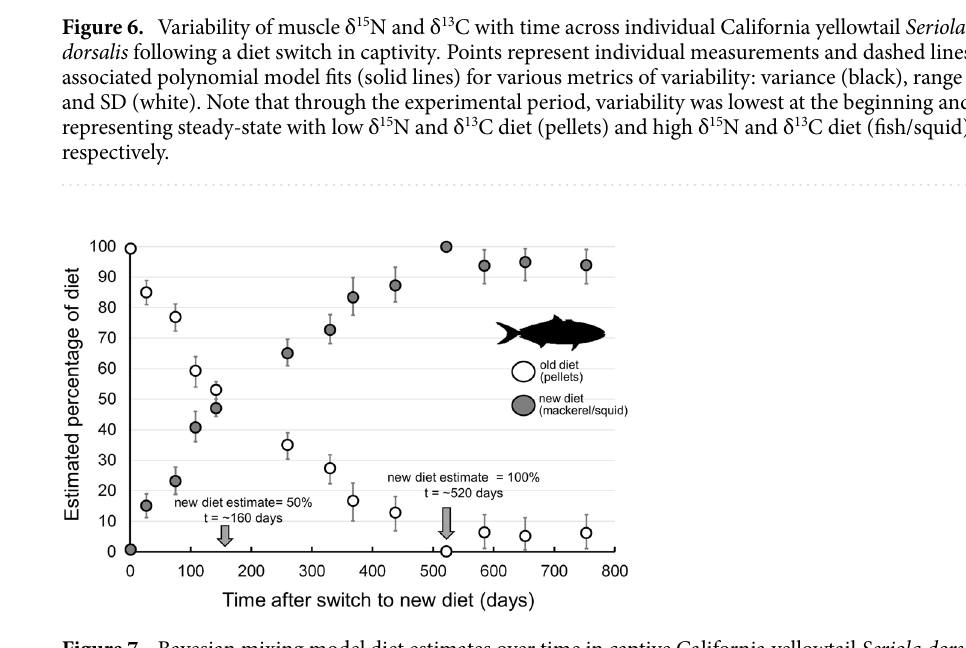
Figure 7. Bayesian mixing model diet estimates over time in captive California yellowtail Seriola dorsalis , showing time (days) required for mixing models to accurately reflect diet switch in yellowtail muscle . Points represent median diet proportion estimates and error bars show 95% credible intervals. Arrows show the approximate time for yellowtail muscle to represent 50% new diet and 100% new diet. Note that ~ 520 days were required for mixing model estimates to correctly show 100% of new diet, representing ~ 3 half-lives for 15 N (181 d) and ~ 1.5 half-lives for 13 C (341 d), as calculated from turnover rates in this